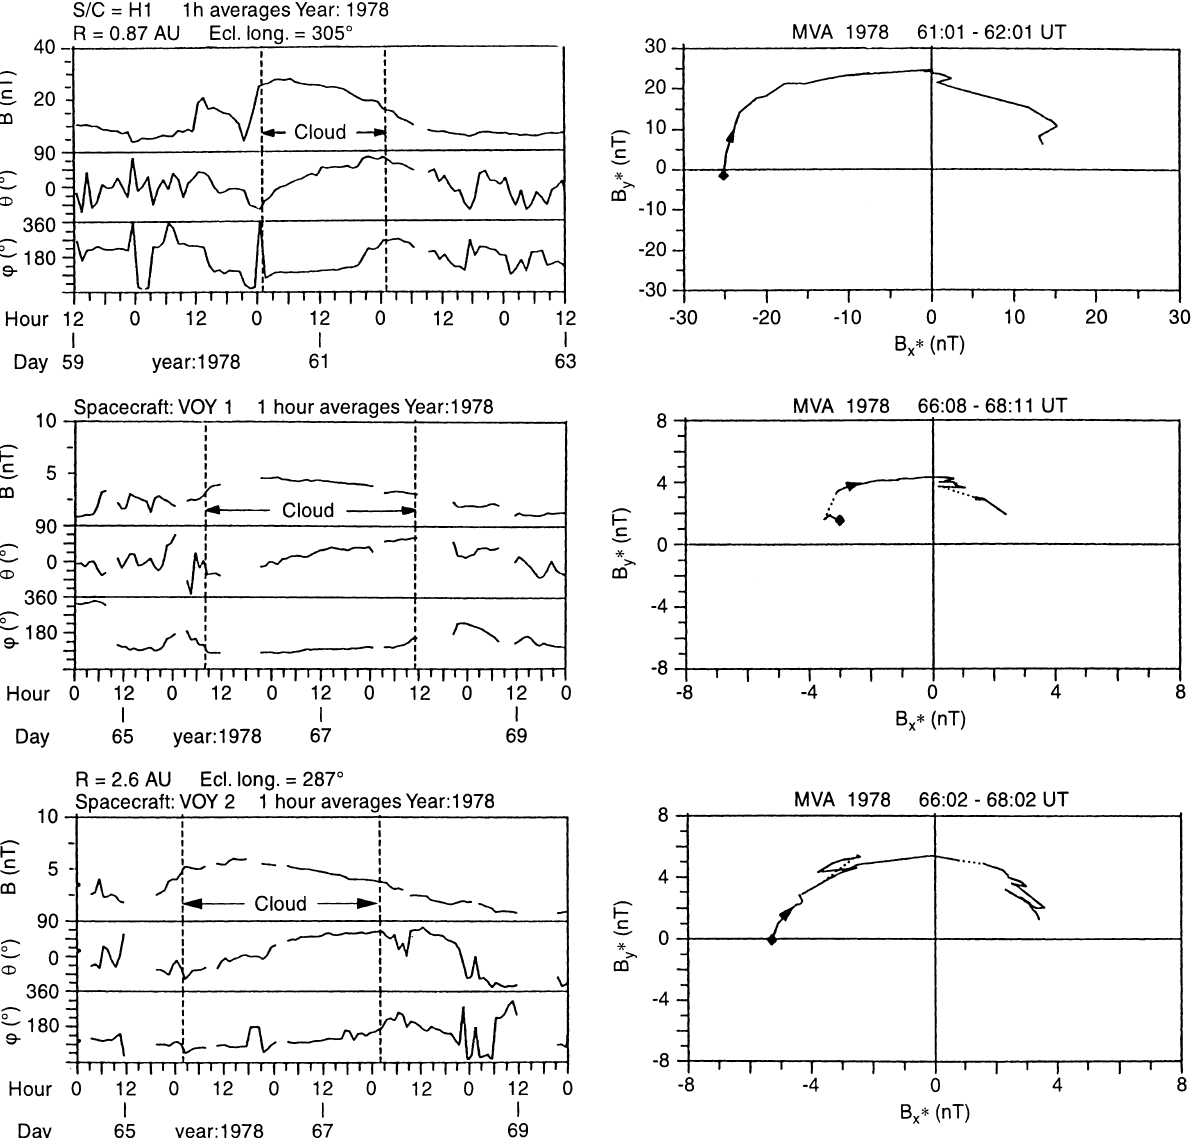
Fig. 13. Magnetic field data and results of the MVA for a MC ( dashed lines ) that passed Helios 1 at 0.9 AU on days 61, 01 UT – 62, 01 UT, Voyager 1 at 2.6 AU on days 66, 08 UT – 68, 11 UT and